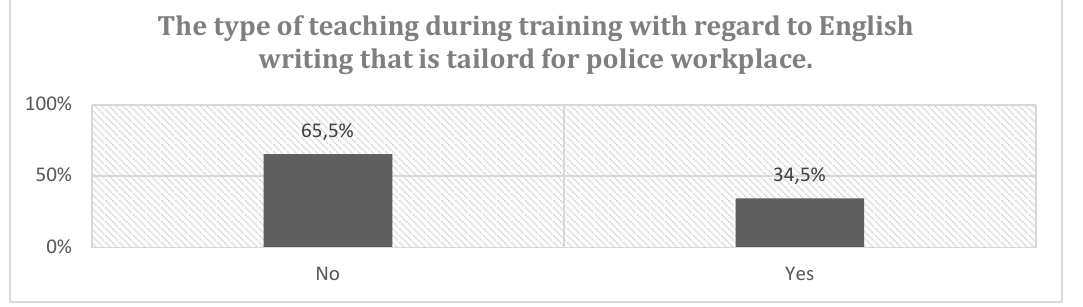
Figure 3. The type of pedagogy in SAPS training